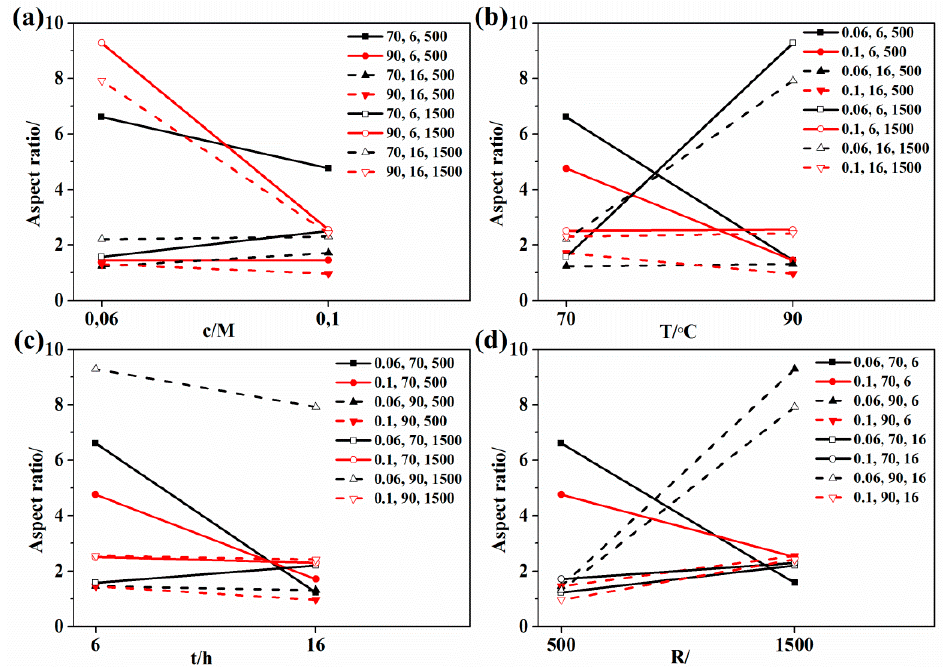
Figure 7. One-pair-at-a-time main e ff ect analysis of varied parameters ( a ) the concentration of Zn 2 + , ( b ) temperature, ( c ) reaction time, and ( d ) molar ration of Zn 2 + to tri-sodium citrate on aspect ratios for the first sixteen experiments in Table